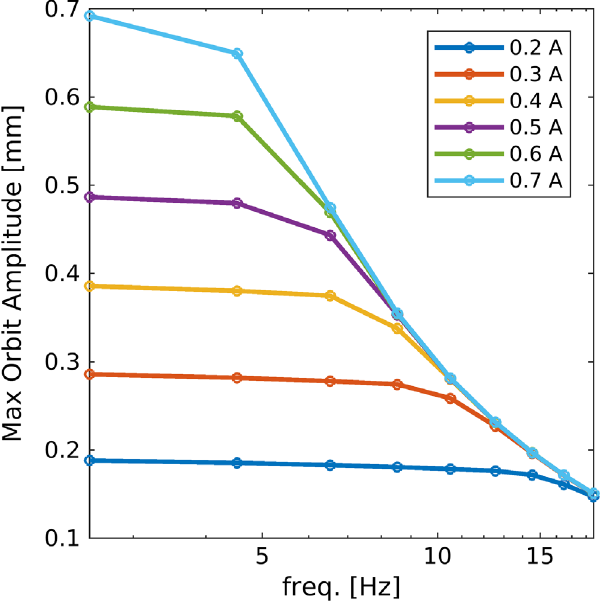
FIG. 8. Maximum orbit distortion over all the 120 BPMs as a function of the waveform amplitude and frequency. A very similar behavior is observed in both planes.